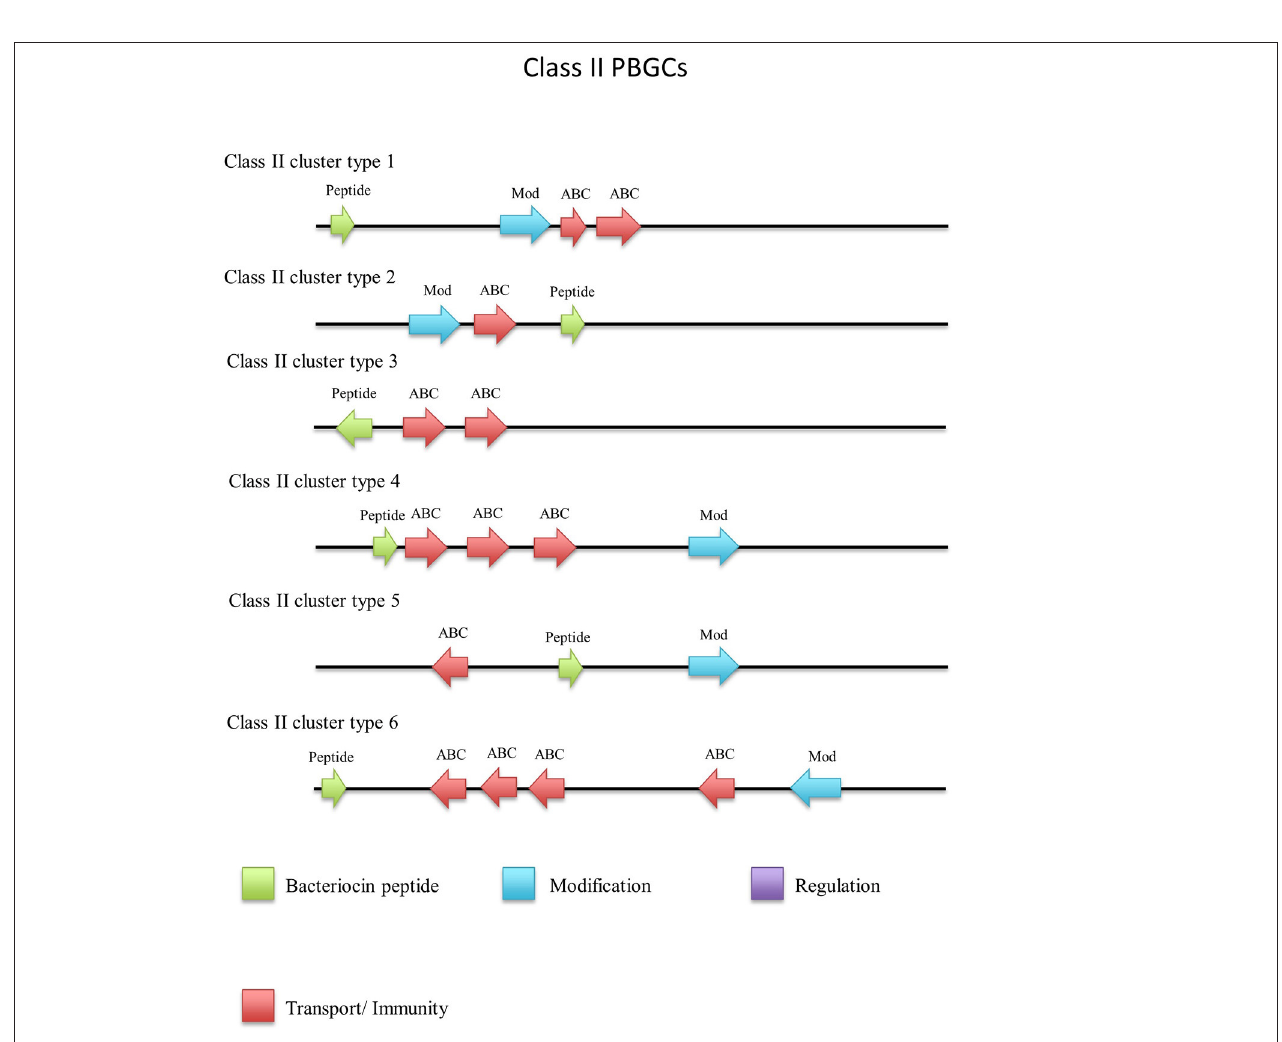
FIGURE 13 | Class II cluster types predicted by